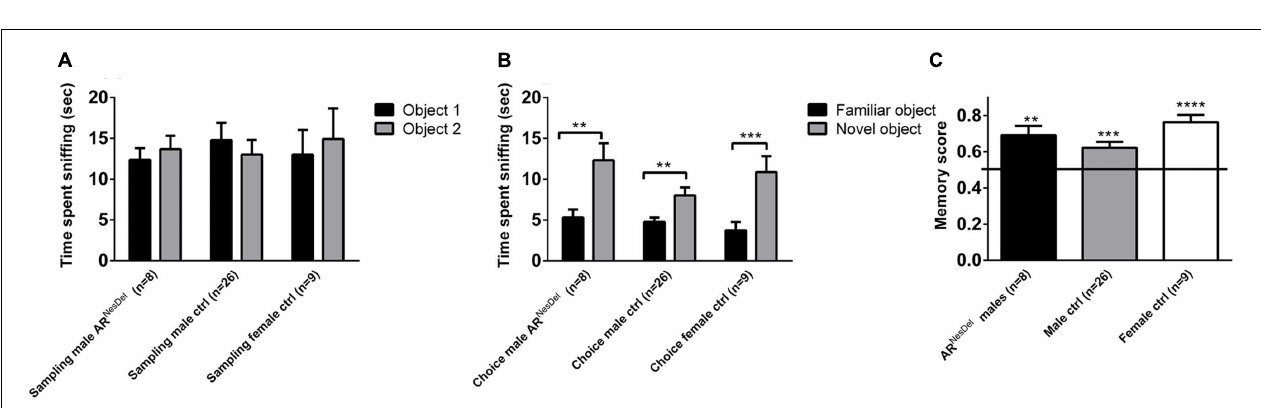
FIGURE 3 | Sociability, social investigation and social recognition measured in the three-chambered apparatus test or the social discrimination paradigm in estrus and non-estrus female controls (ARflox + / − ). (A) Amount of time spent in each chamber and (B) sniffing the novel mouse during the 10 min test of sociability in the three-chambered apparatus. (C) Amount of time sniffing novel female and male stimulus mice in the sampling phase of the social discrimination paradigm. (D) Social memory score when presented to female or male stimulus animals. Bars represent mean ± SEM, ∗ p < 0.05, ∗∗∗ p < 0.001 (for within-group comparison).